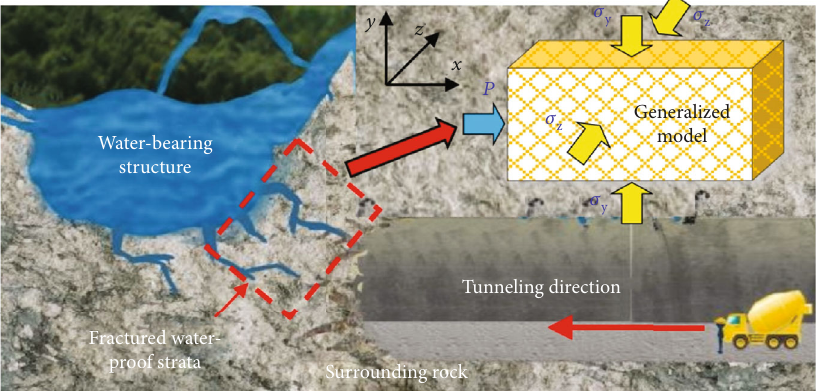
Figure 2: Schematic diagram of water inrush disaster in a typical underground